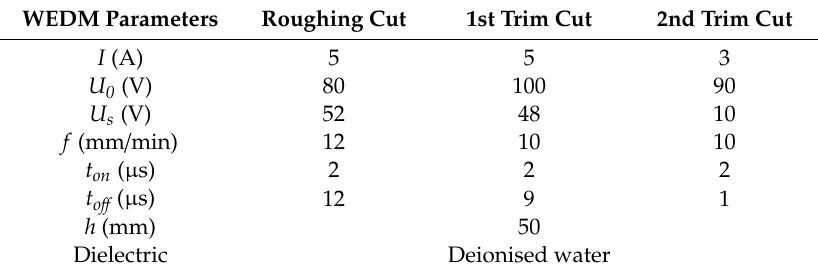
Table 1. Electrical parameters for single discharge experiments.